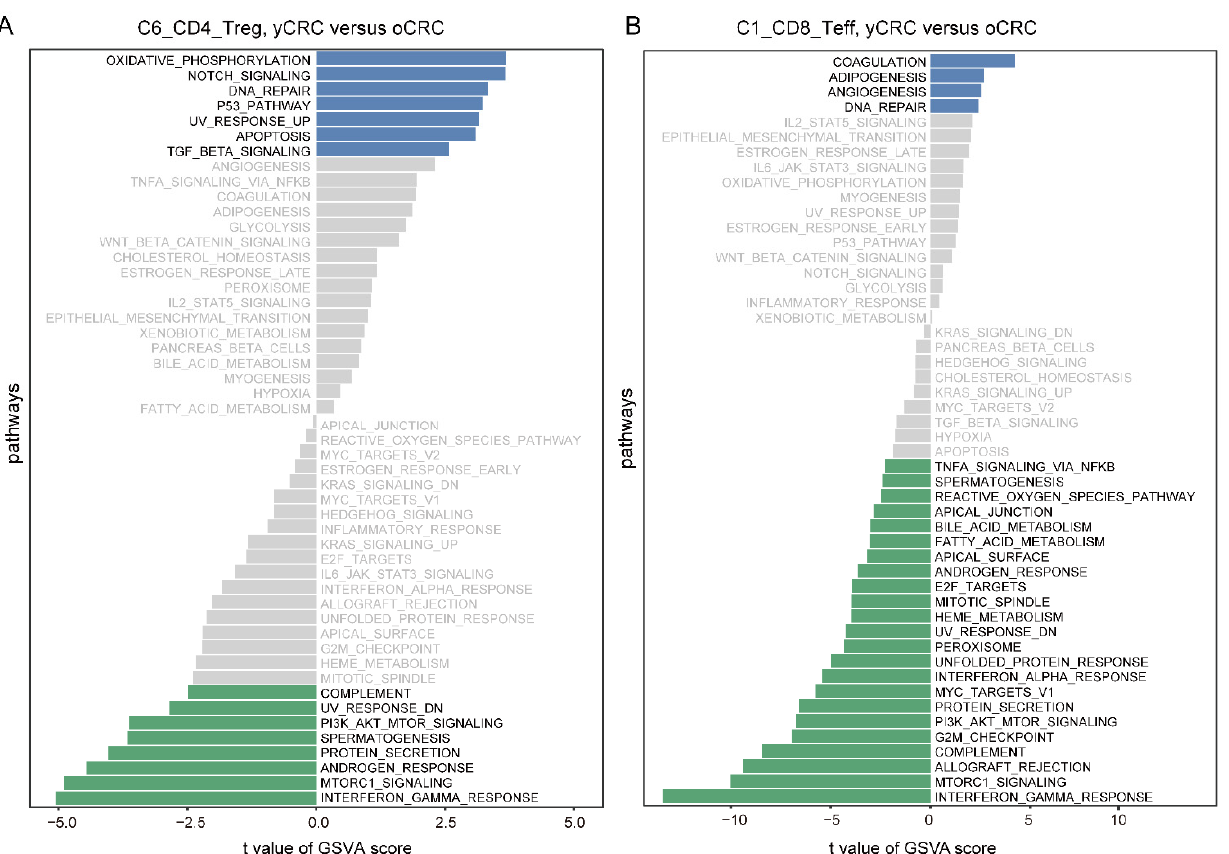
Figure 3. Pathway differences between Treg cells and effector T cells between yCRC and oCRC. ( A ) Differences in Hallmark pathways activities scored per cell by GSVA between yCRC and oCRC C6_CD4_Treg cells. t values are from linear models, corrected for effects from the patient of origin. ( B ) Differences in Hallmark pathways activities scored per cell by GSVA between yCRC and oCRC C1_CD8_Teff cells. t values are from linear models, corrected for effects from the patient of origin.